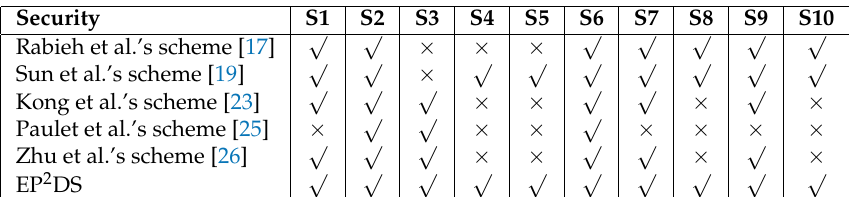
Table 2. Security comparisons. Efficient privacy-preserving data sharing (EP 2 DS), and × denotes “does not satisfy”.